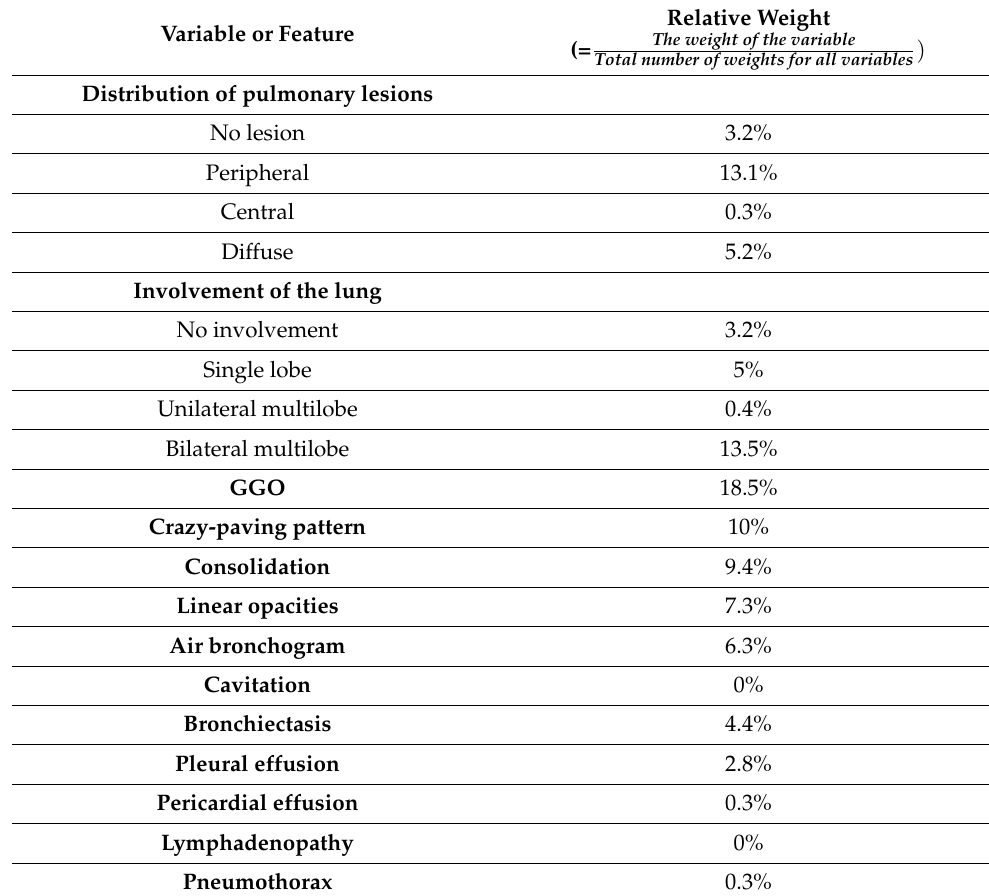
Table 4. The variables of the chest CT image, along with their calculated relative